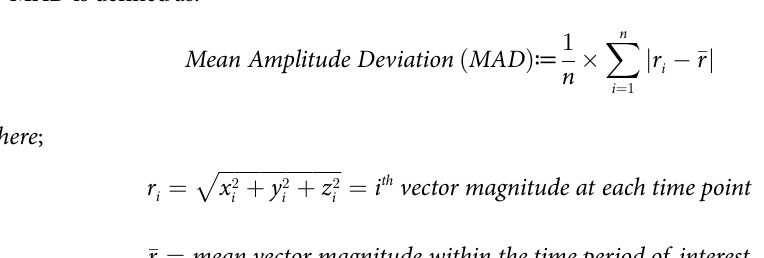
acceleration files were converted to time-stamped .csv files, which were then exported into Stata/IC V13.1 (Stata Corporation, College Station, Texas, USA) for processing and analysis. The laboratory log sheets (with the observedstart and end times of each activity) were utilised for identifying each activity in the time-stamped .csv files.